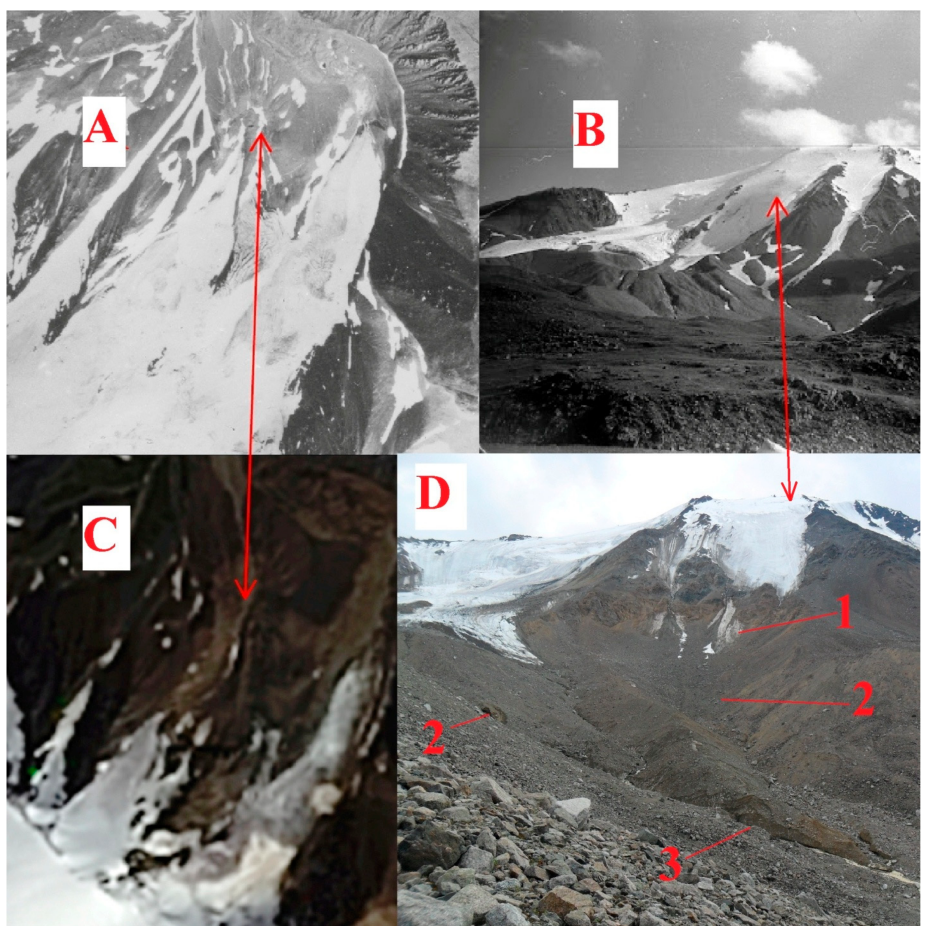
Figure 14. Degradation of the Glacier No. 9 in the Right Mugur valley, Mongun-Taiga: ( A ) aerial image, (10 July 1966); ( B ) photo by the authors (July 1994); ( C ) Landsat-8 image (12 August 2013); ( D ) photo by the authors (July 2011). 1. Debris-covered part of a glacier cut off by the rock bar in 1994–2008; 2. parts of glaciers that were debris-covered in the interval 1966–1994; 3. ex-medial moraine with ice core. Arrows show Glacier No.